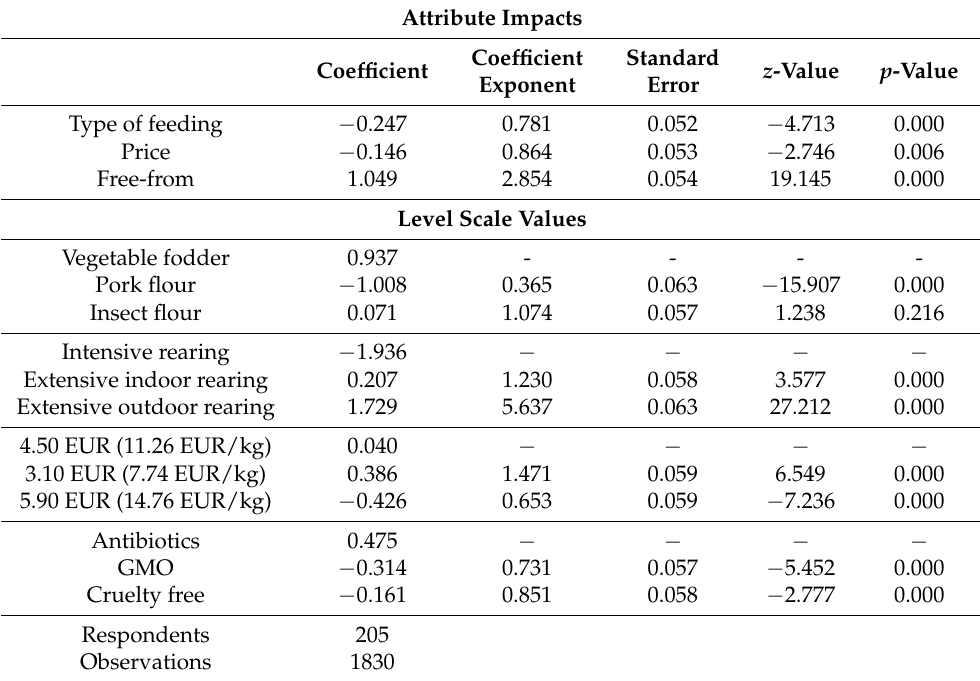
Table 4. Conditional logit model